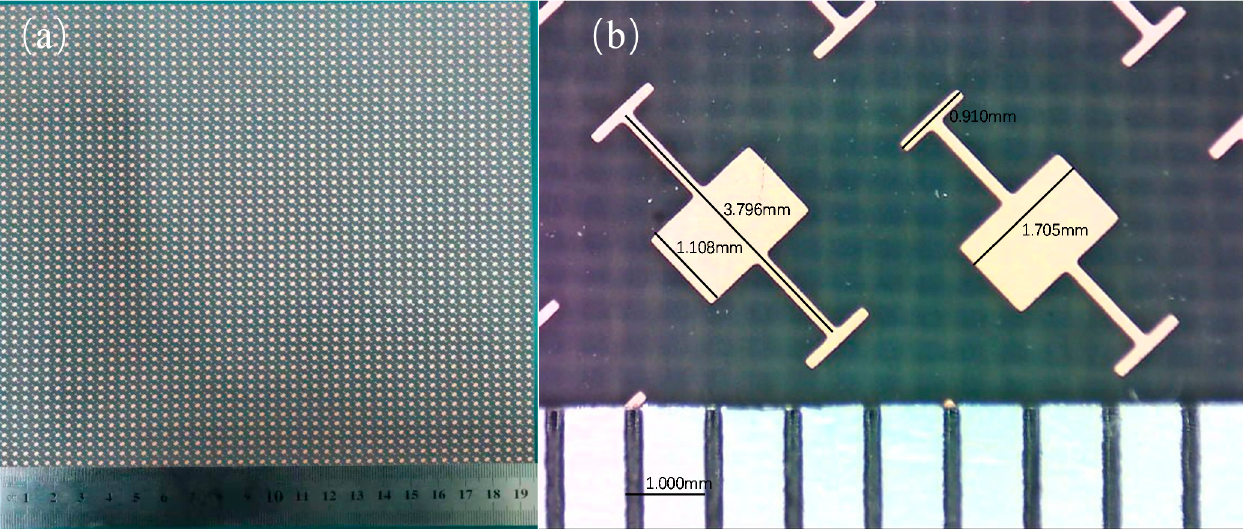
Figure 6. The fabricated prototype. ( a ) Photography in comparison with a ruler; ( b ) image under an industrial microscope with marked size.